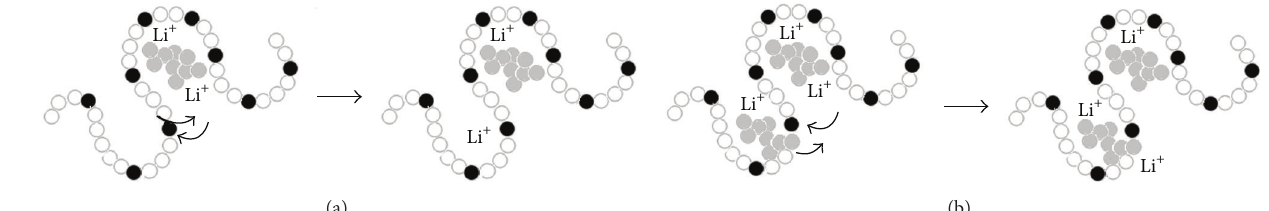
Figure 8: Grain boundary diffusion: (a) intrachain diffusion and (b) interchain diffusion.